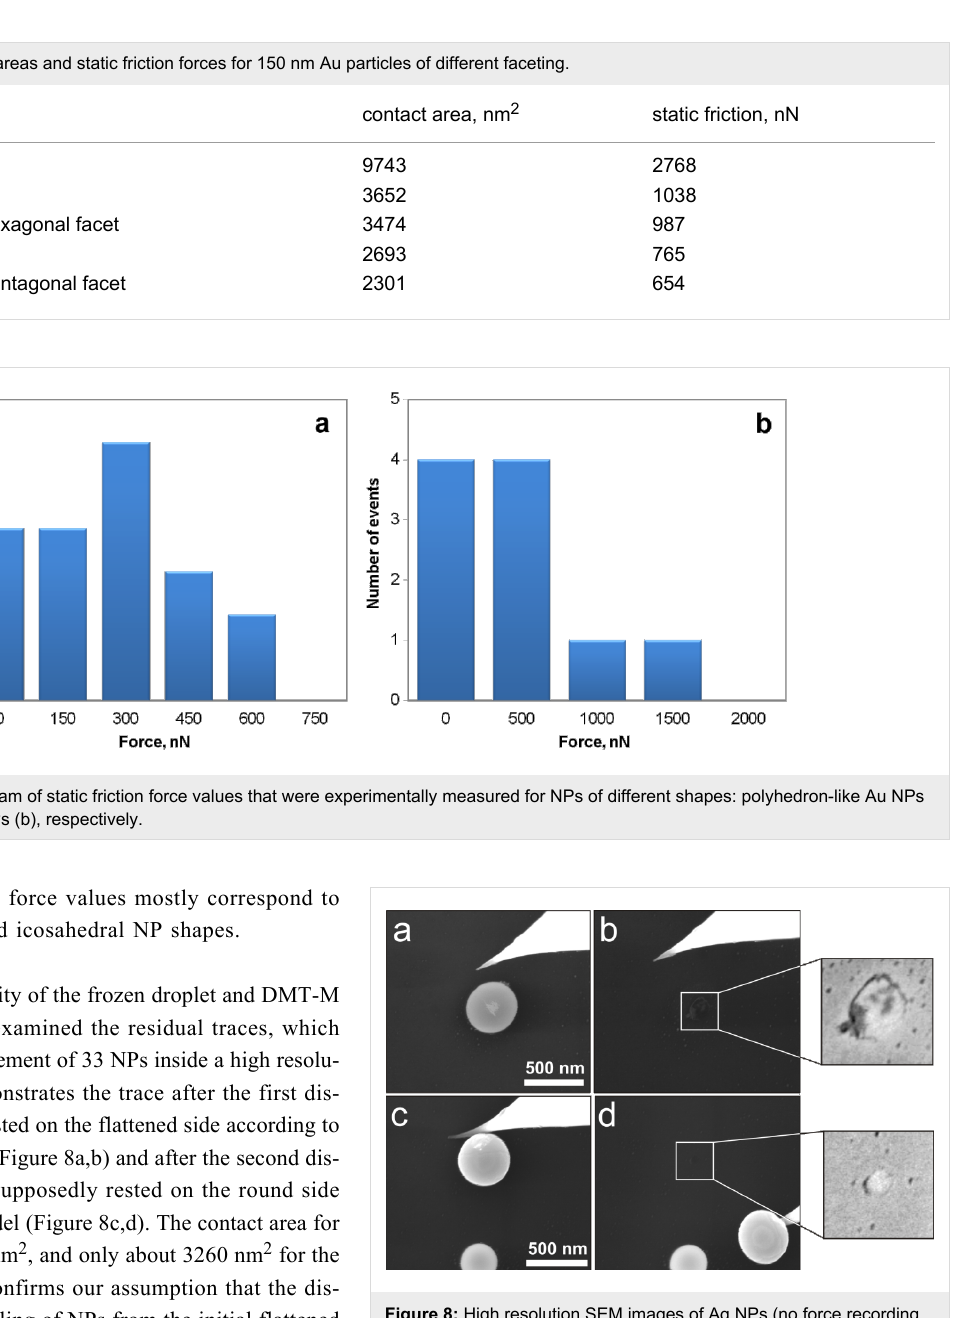
Figure 8: High resolution SEM images of Ag NPs (no force recording during the displacement of the NPs). Traces indicating the contact area after the first (a,b) and the second (c,d) displacement of two different Ag NPs. The corresponding estimated static friction forces are ca. 6190 nN and about 930 nN,